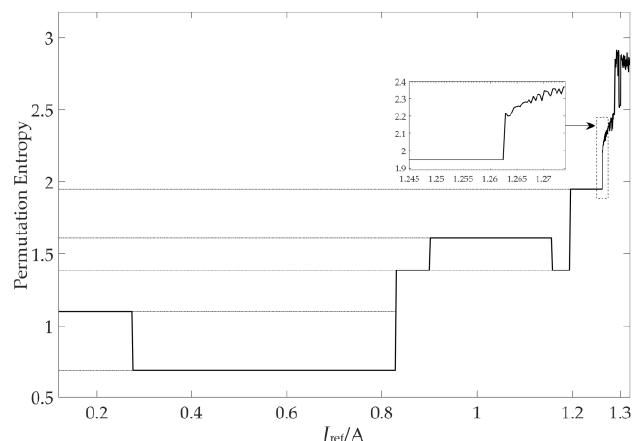
Figure 7. Permutation entropy of buck converter with I ref as the changing parameter.